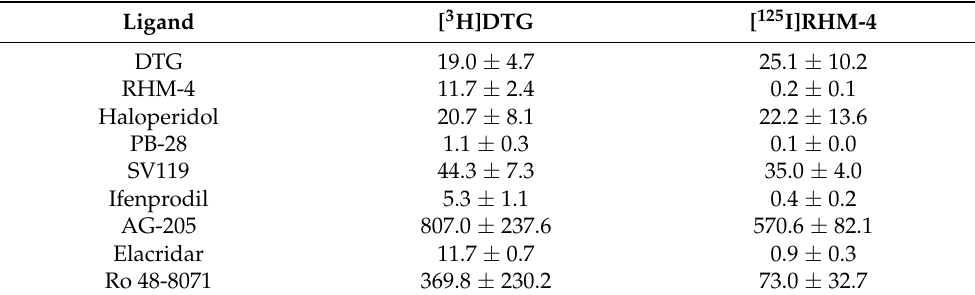
Table 1. Different inhibition constants (Ki, nM) of the nonradioactive ligands competing with [ 3 H]DTG or [ 125 I]RHM-4 using SD rat liver membrane.